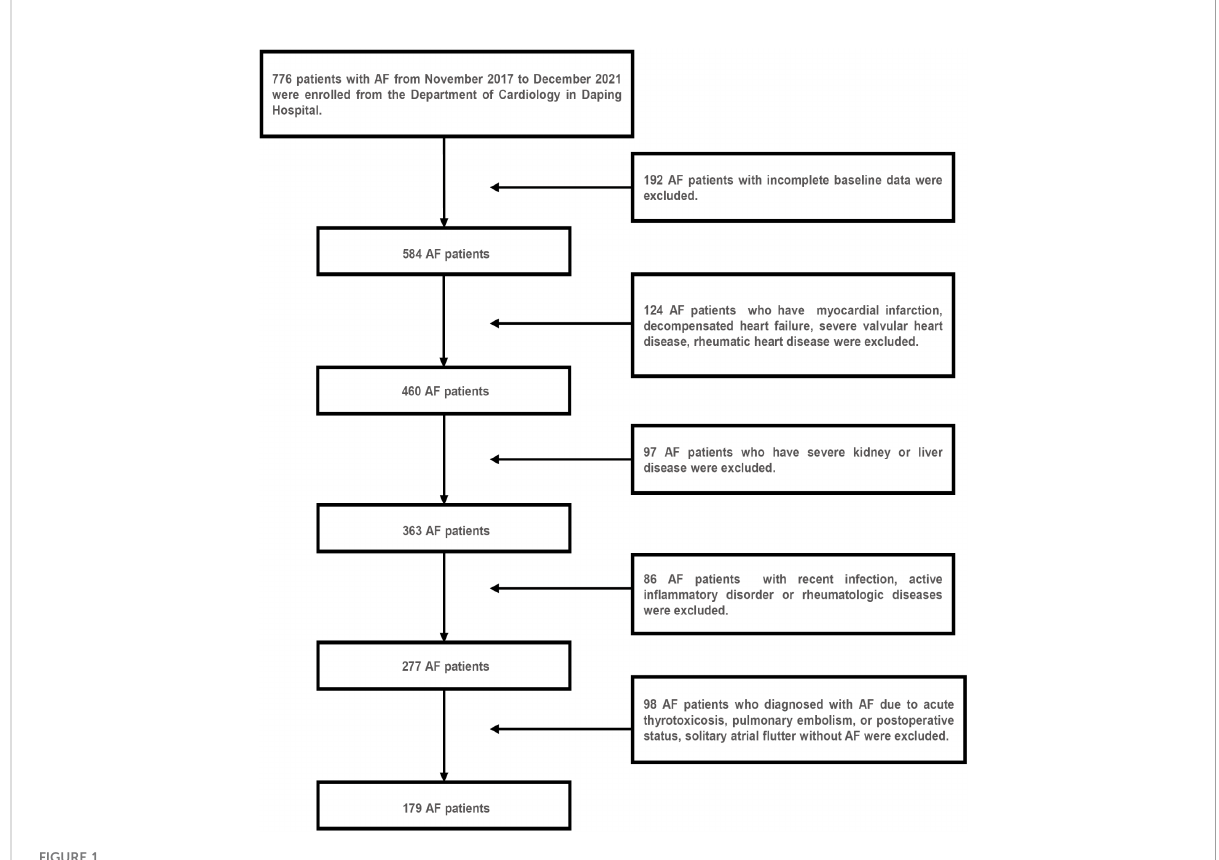
FIGURE 1 Flow chart of study selection for the AF